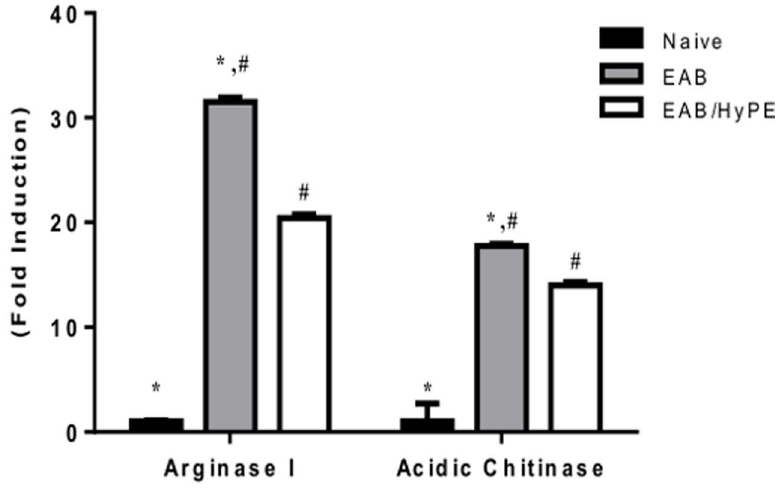
Figure 2. mRNA expression of arginase- I and acidic chitinase in lungs of EAB mice. mRNA of arginase-I and acidic chitinase in lungs was determined by RT-PCR. Each datum is mean 6 SEM for 10 mice in a group. *, # P ,